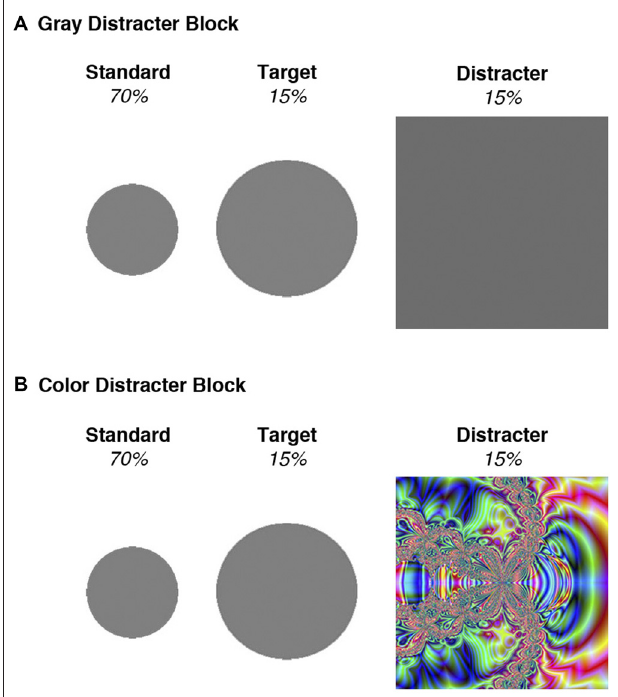
FIGURE 1 | Stimuli used in the two blocks of the oddball task. (A) All stimuli in the gray distracter block were comprised of an identical gray color. (B) Standards and targets in the color distracter block were identical to those presented in the gray distracter block, but the distracters consisted of unique colorful fractal